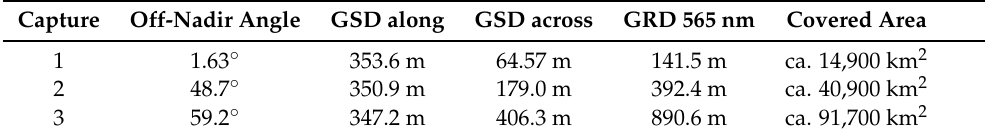
Figure 7. Ground sampling (“pixel-to-pixel”) distances of three captures with different off-nadir angles, determined using direct geo-referencing. No slewing maneuver was performed [5]. The left plot shows along track, and the right plot shows across track GSD. HYPSO-1 was holding a constant orientation during capture with respect to a reference frame co-moving with satellite and aligned with its orbital track. The y -axis range is equal for along- and across track for easier comparison between them. Table 4. Off-nadir angle, mean GSD’s in the along and across track directions and estimated GRD in terms of meters on ground across track for the three captures in Figure 7. The across track GRD is found using the LSF FWHM of 2.192 pixels for band 565 nm. Variation in along track GSD can due to noise in the ADCS